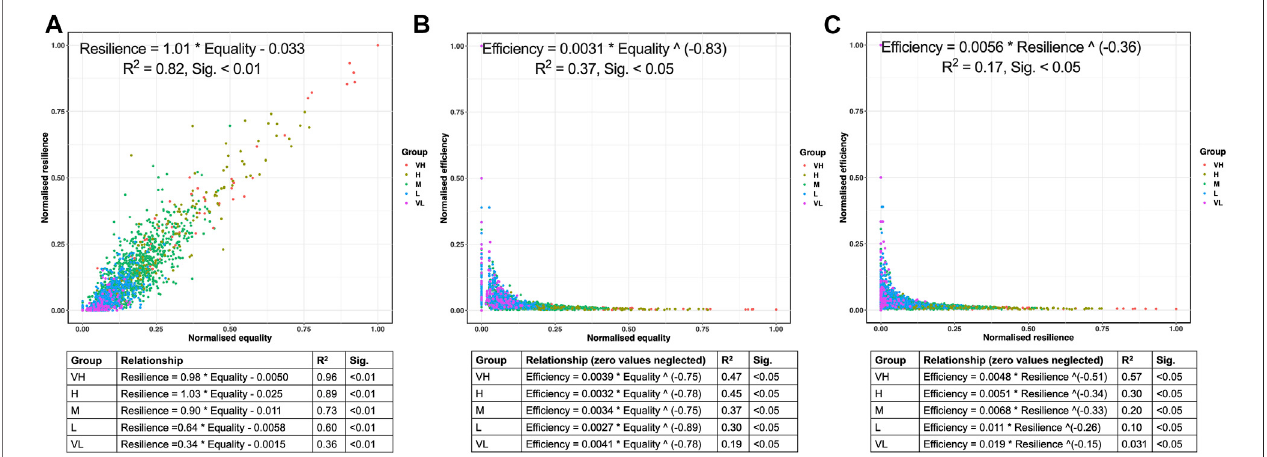
FIGURE 4 | Relationships of structural metrics between: (A) resilience and equality, (B) ef fi ciency and equality, and (C) ef fi ciency and resilience among the fi ve publication